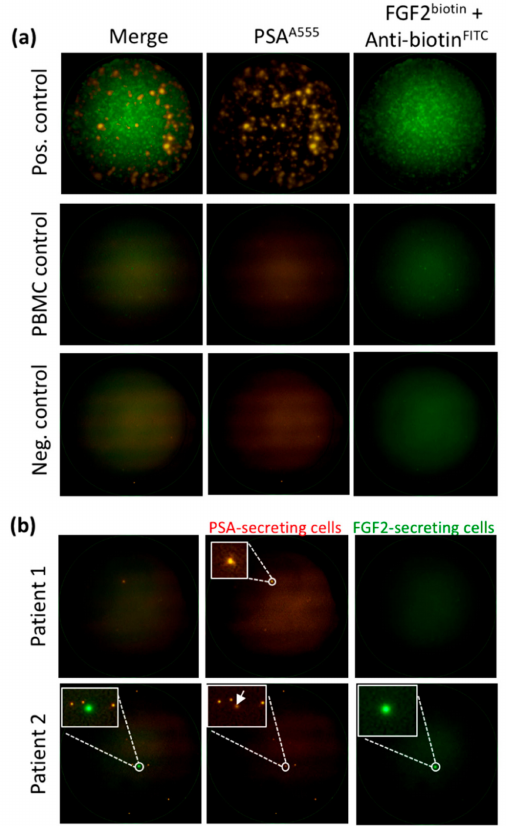
Figure 3. Detection of viable CTCs using the dual fluorescent EPISPOT PSA / FGF2 assay. ( a ) Positive and negative controls. LNCaP (shown in figure) and NBTII cells that secrete PSA and FGF2, respectively, were used as positive controls (2000 cells / well), whereas wells with peripheral blood mononuclear cells (PBMC) and without cells were used as negative controls. Each immuno-spot corresponds to the protein “fingerprint” of one viable cell. ( b ) Patient samples. PSA-secreting cells are considered as CTCs in blood samples from patients with PCa (Patient 1). A subset of CTCs can secrete FGF-2 in addition to PSA (Patient 2). Representative images of PSA-positive, FGF2-positive and double PSA / FGF2 immuno-spots (merge) corresponding to viable CTCs. Immuno-spots were detected and observed using the C.T.L. Elispot Reader, 50 ×